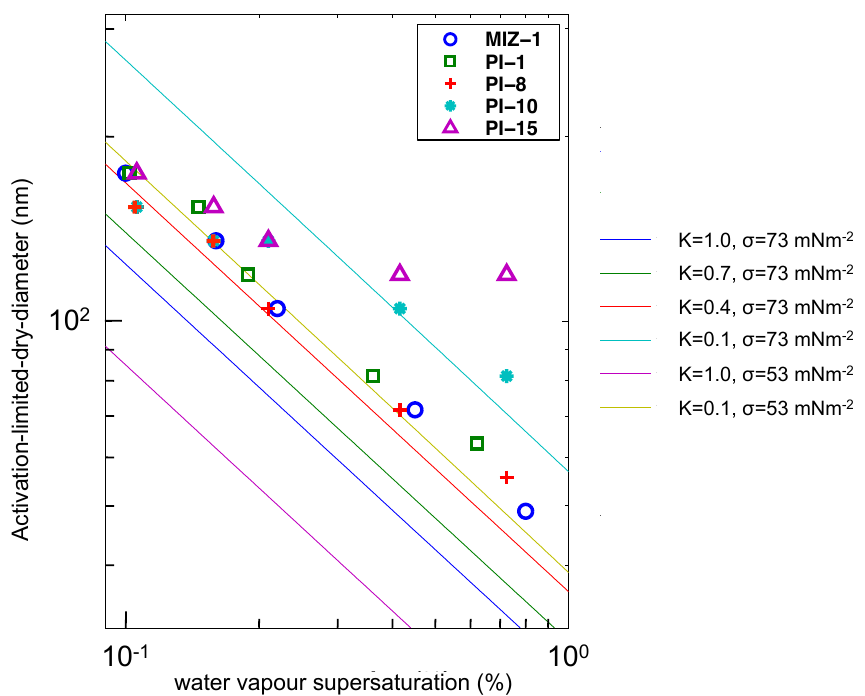
Figure 7. κ -Köhler theory predictions of the aerosol activation-limit dry diameter for assumed pairs of κ and σ (lines) compared to values derived from the impactor samples MIZ-1, PI-1, PI-8, PI-10 and PI-15 (symbols).